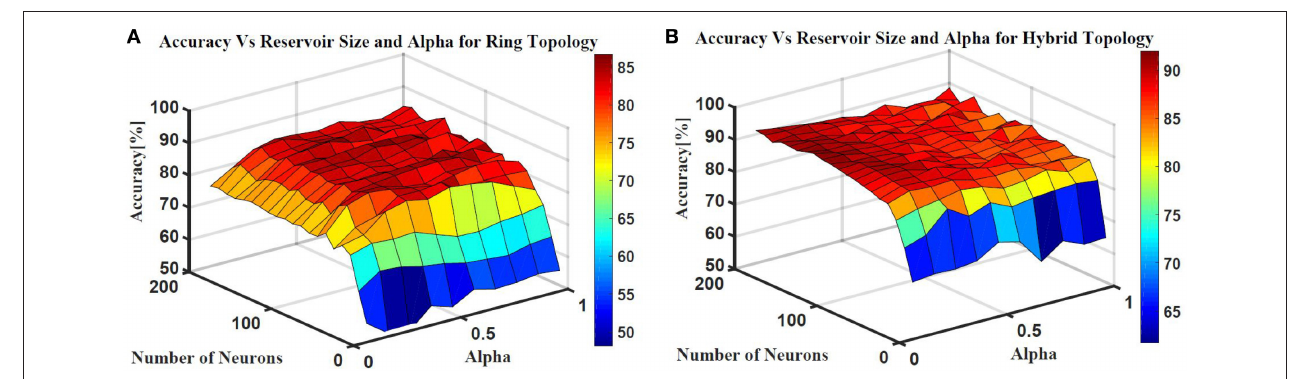
FIGURE 10 | Epileptic seizure detection accuracy vs.the reservoir size and alpha for (A) Ring topology with maximum accuracy of 86 % and (B) Hybrid topology with maximum accuracy of 90 %.